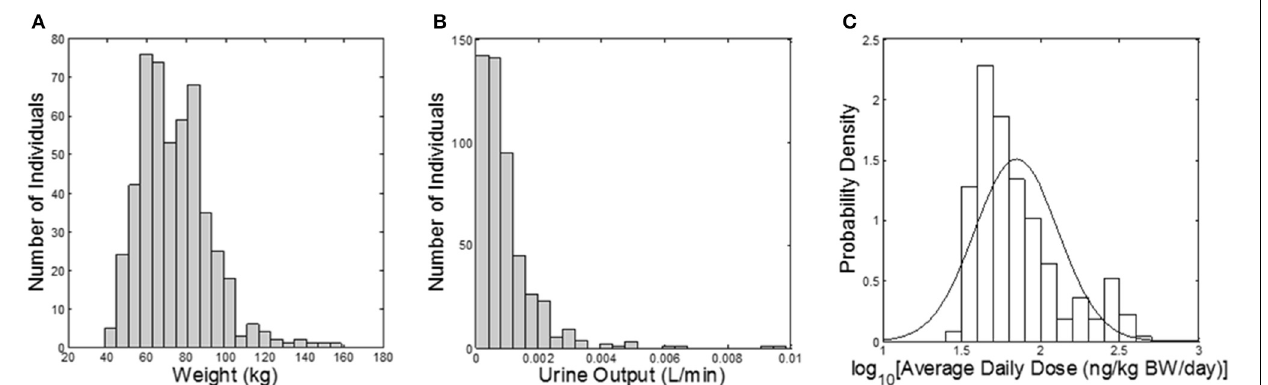
FIGURE 1 | Model inputs from CARES and NHANES. (A) Histogram of subject body weights (kg); (B) histogram of urine flow rates (L/min) assigned from NHANES; (C) probability density of the daily dose of carbaryl averaged